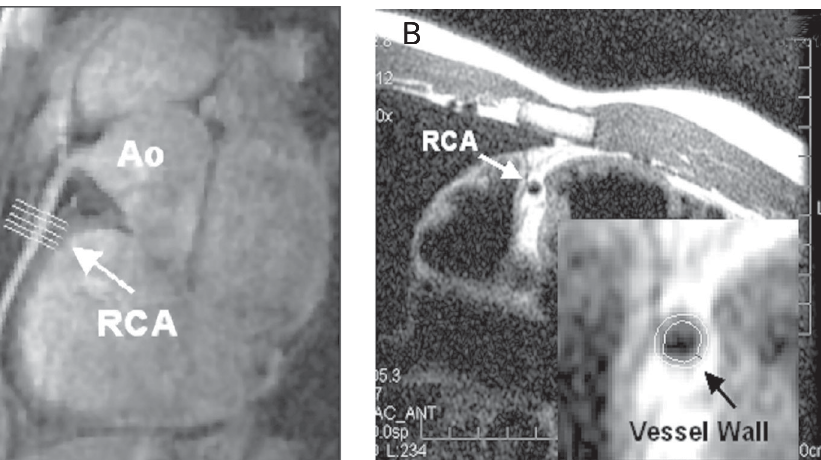
Figure 1. Magnetic resonance imaging (MRI) of a 26-year-old healthy male subject. Double- oblique view of the right coro- nary artery (A) with transverse prescription and cross-sectional black-blood magnetic reso- nance images of circular lumen and thin wall in magnified view (B). Ao = aorta; RCA = right coronary